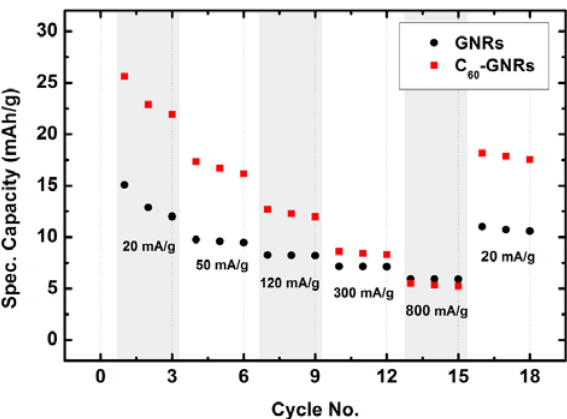
Figure 5 . Rate capability for non-functionalized GNRs (black circles) and functionalized C -GNRs (red squares) at 20 mA/g, 60 50 mA/g, 120 mA/g, 300 mA/g, and 800 mA/g current